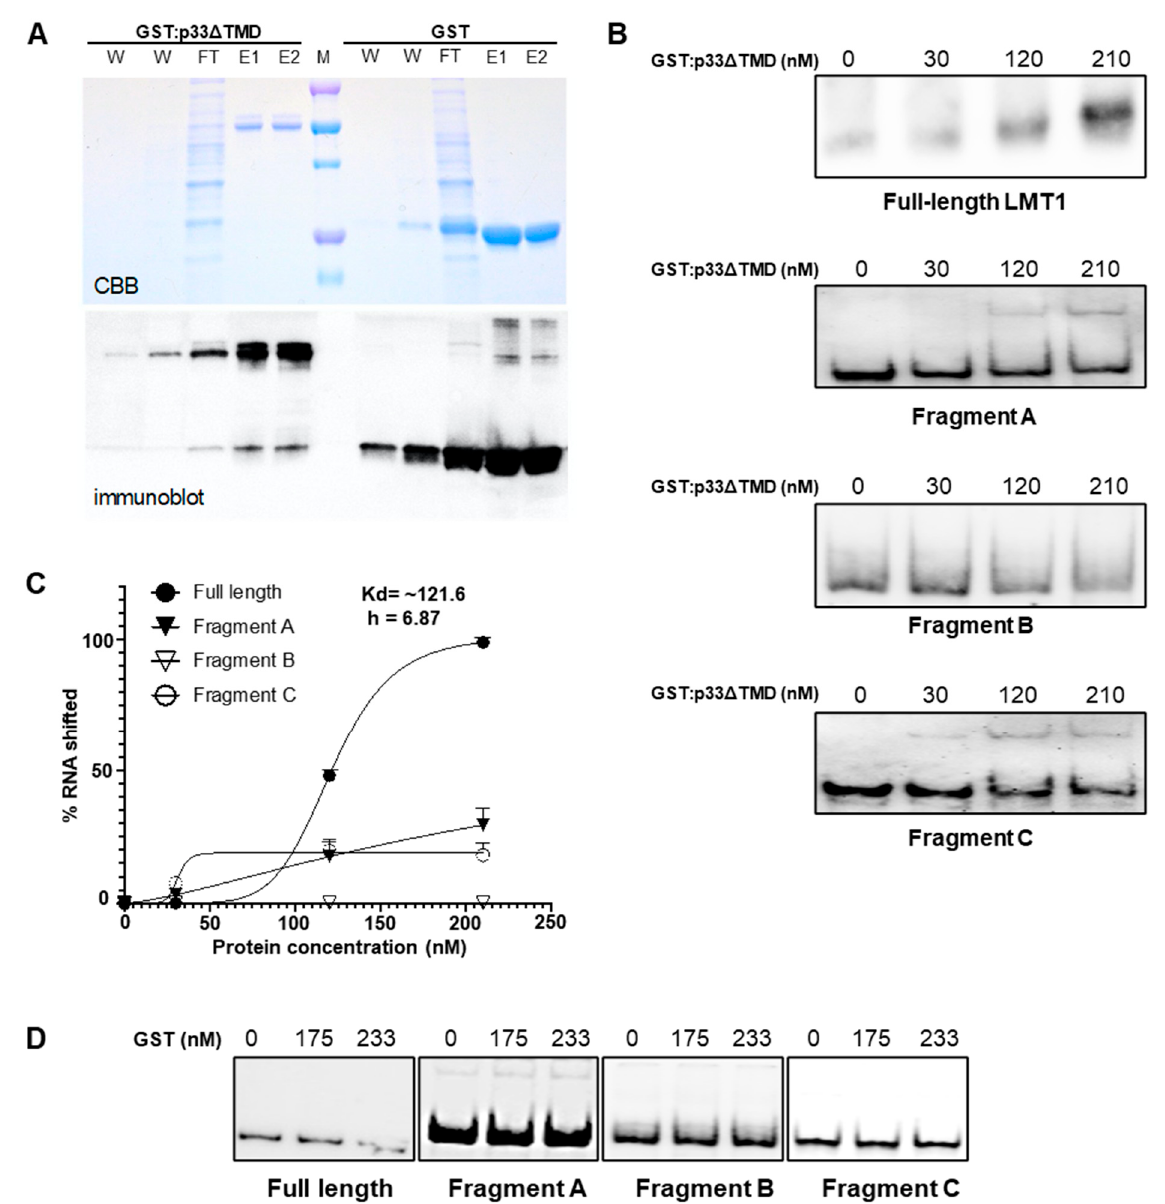
Figure 5. In vitro binding of purified p33 protein and LMT1 RNA or its truncated versions. ( A ) SDS-PAGE analysis of purified GST:p33 ∆ TMD and GST proteins followed by Coomassie Brilliant Blue (CBB) staining. Proteins were verified using an anti-GST antibody after the transfer to the PVDF membrane (immunoblot). W, wash fraction; FT, flow-through fraction; E, elution fraction. ( B ) Kinetics of p33 and LMT1 binding was analyzed using a PAGE loaded with a series of varying amounts of purified GST:p33 Δ TMD with the same amount of LMT1 transcripts or LMT-1-derived fragments. ( C ) The binding kinetics between p33 and LMT-1 or LMT1-derived fragments were plotted to the Hill equation. The Kd and Hill coefficient (h) of p33 affinity to full-length LMT1 are listed. ( D ) GST alone did not bind with any of the tested RNA as shown by EMSA.